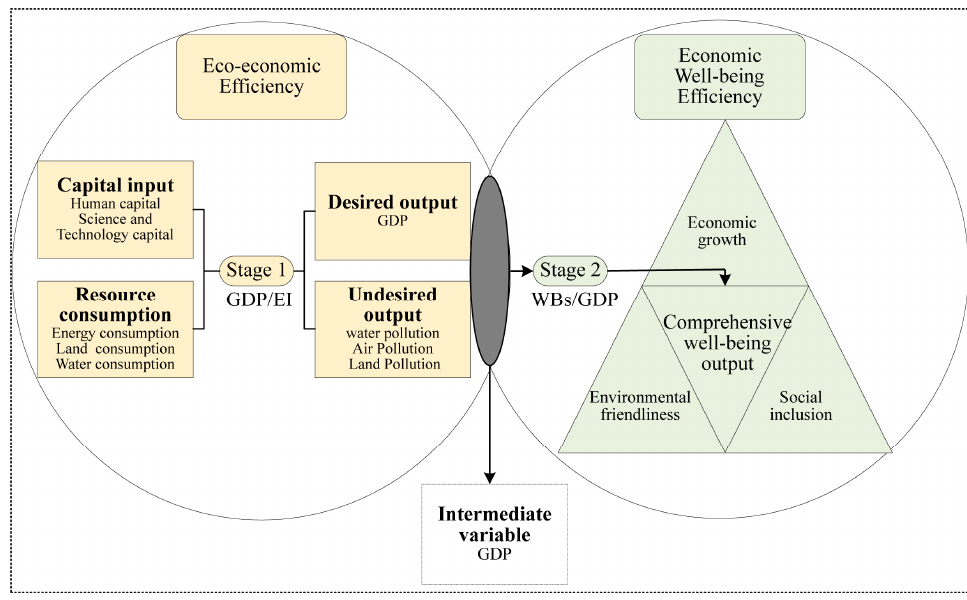
Figure 2. Eco-economic efficiency and economic well-being efficiency transformation system of EWP in